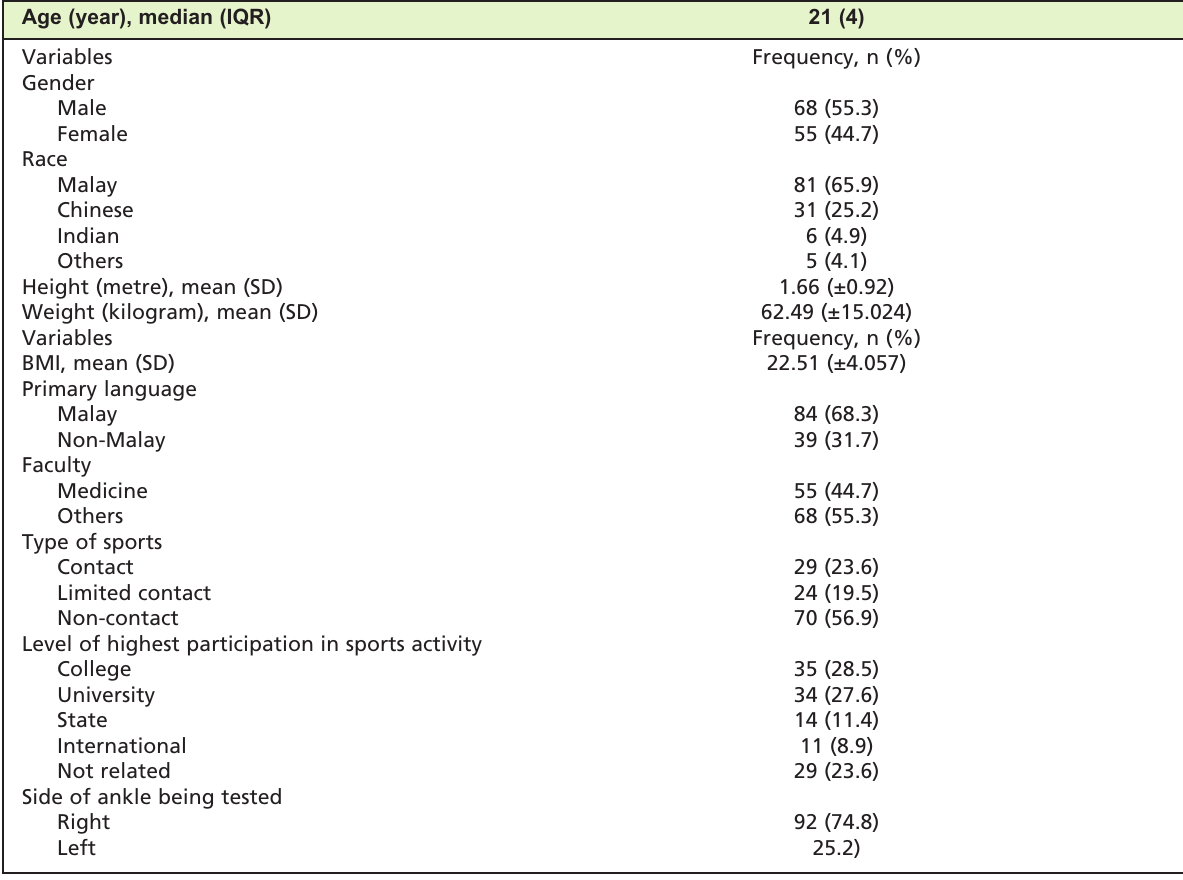
Descriptive profile of the study participants (n=123) Table I: